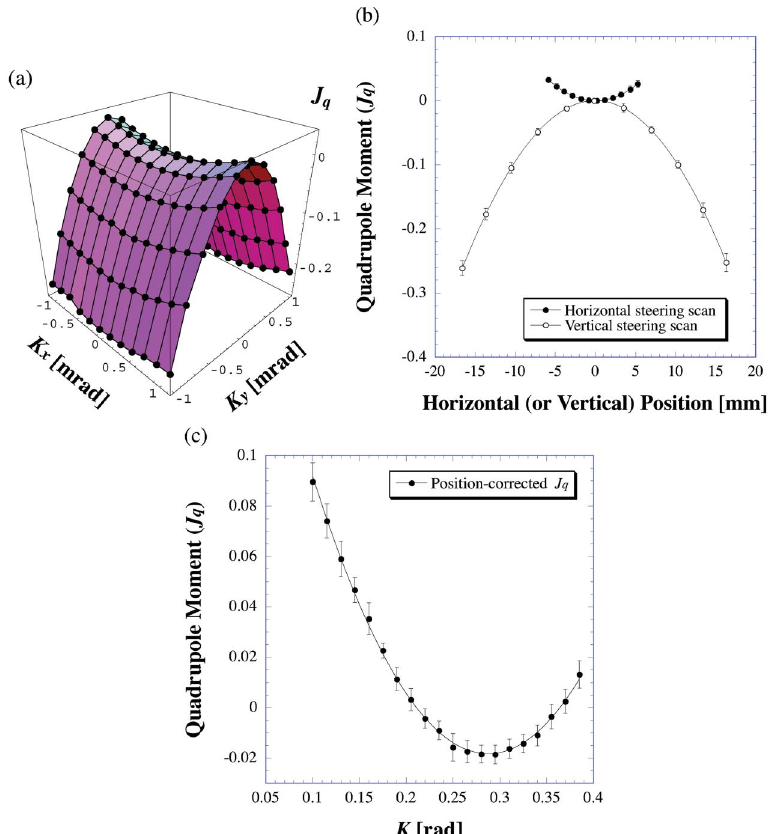
FIG. 5. (Color) Beam-based calibration results of the energy-spread monitor installed at the 3.5-GeV positron beam line. (a) Three- dimensional plot in the variations of the quadrupole moment as functions of the kick angles of the upstream horizontal ( K ) steering magnets. (b) Variations of the quadrupole moment as a function of the horizontal (vertical) beam position fixed at vertical ( K y